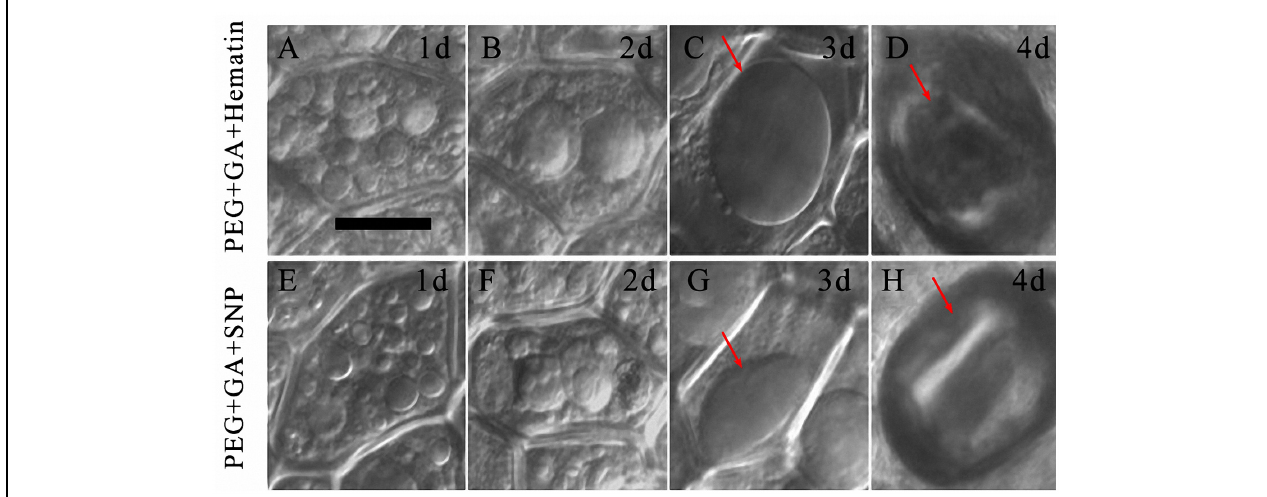
FIGURE 7 | Ht and SNP delayed vacuolation in aleurone cells treated with PEG plus GA. (A–D) Vacuoles of aleurone cells treated with 20% PEG + 50 μ M GA + 1 μ M Ht at 1, 2, 3, and 4 days. (E–H) Vacuoles in aleurone cells treated with 20% PEG + 50 μ M GA + 200 μ M SNP for 1, 2, 3, and 4 days. The scale is 20 μ